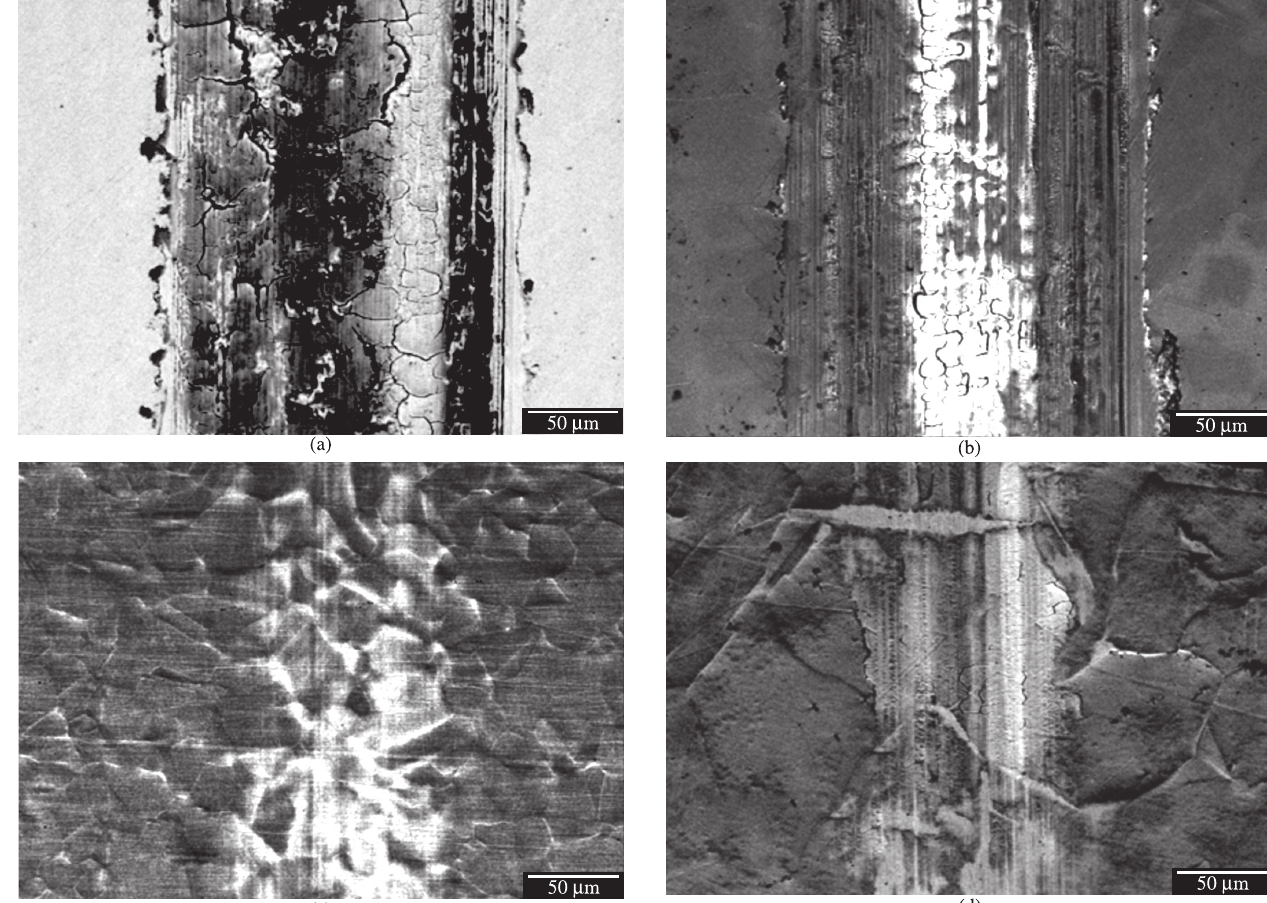
Figure 6. SEM images of tracks produced by ball sliding during tribological tests. (a) AISI 304 – 300 °C; (b) AISI 316 – 300 °C; (c) AISI 304 – 500 °C and (d) AISI 316 – 500